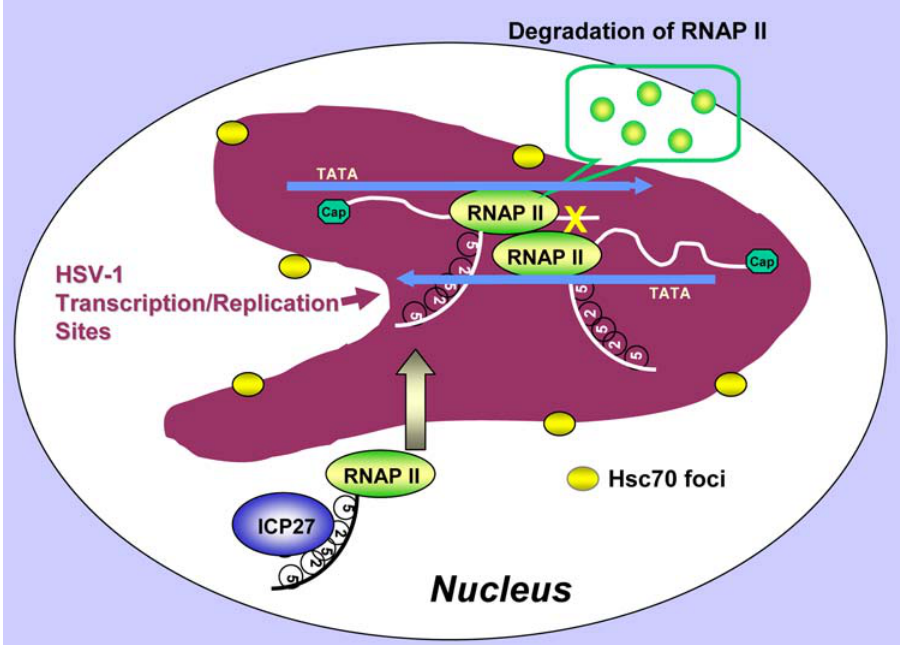
Figure 11. Model of RNAP II Degradation during HSV-1 Transcription. ICP27 interacts with the CTD of RNAP II [11] and recruits RNAP II to a viral replication compartment [11,34], which is represented in magenta. Elongating RNAP II complexes on opposite DNA strands may collide causing one or both complexes to stall. At least one of the stalled complexes may then be ubiquitinated and degraded by the proteasome. The other transcription complex is now free to continue. Hsc70 foci, which form at the same time as replication compartments, and which lie at their periphery, may aid this process by providing a ready source of chaperone proteins as well as other components of the 26S proteasome [6,7].